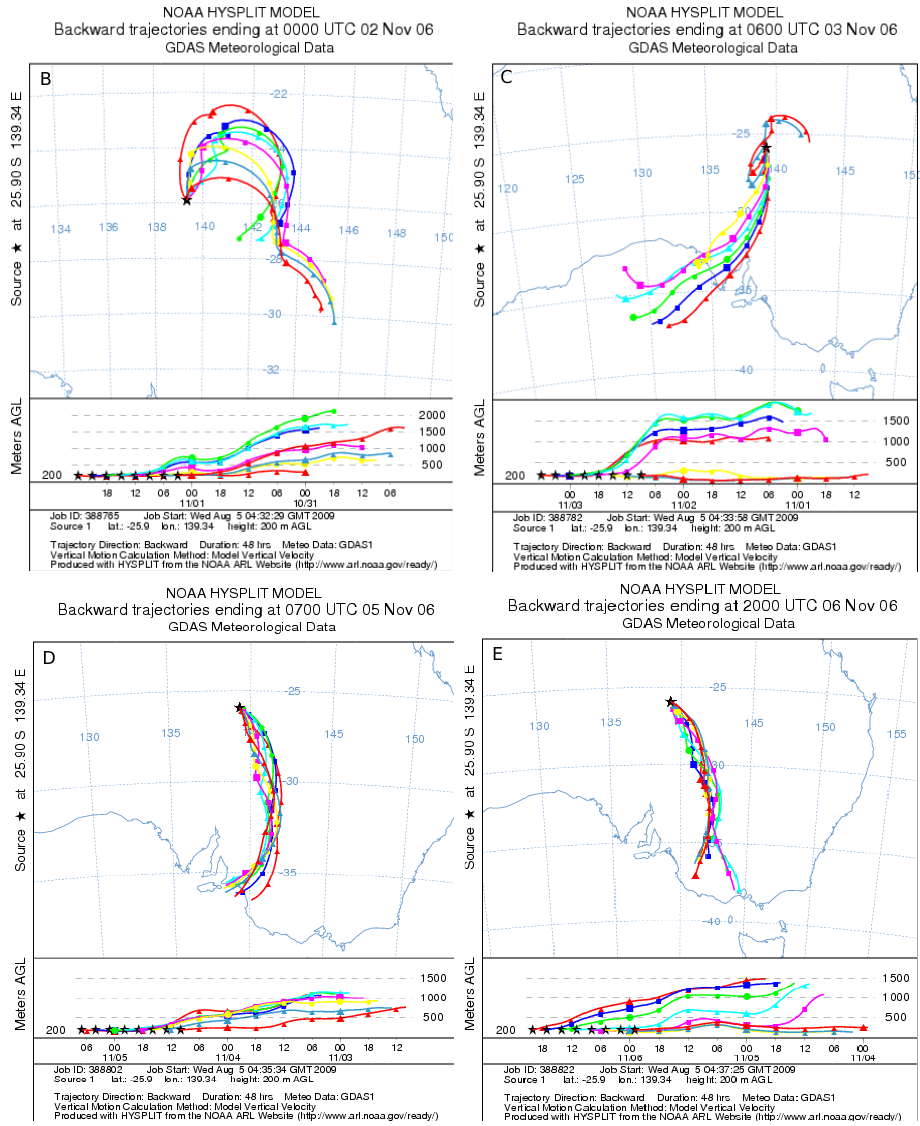
Fig. 10. Back-trajectories during aerosol sampling